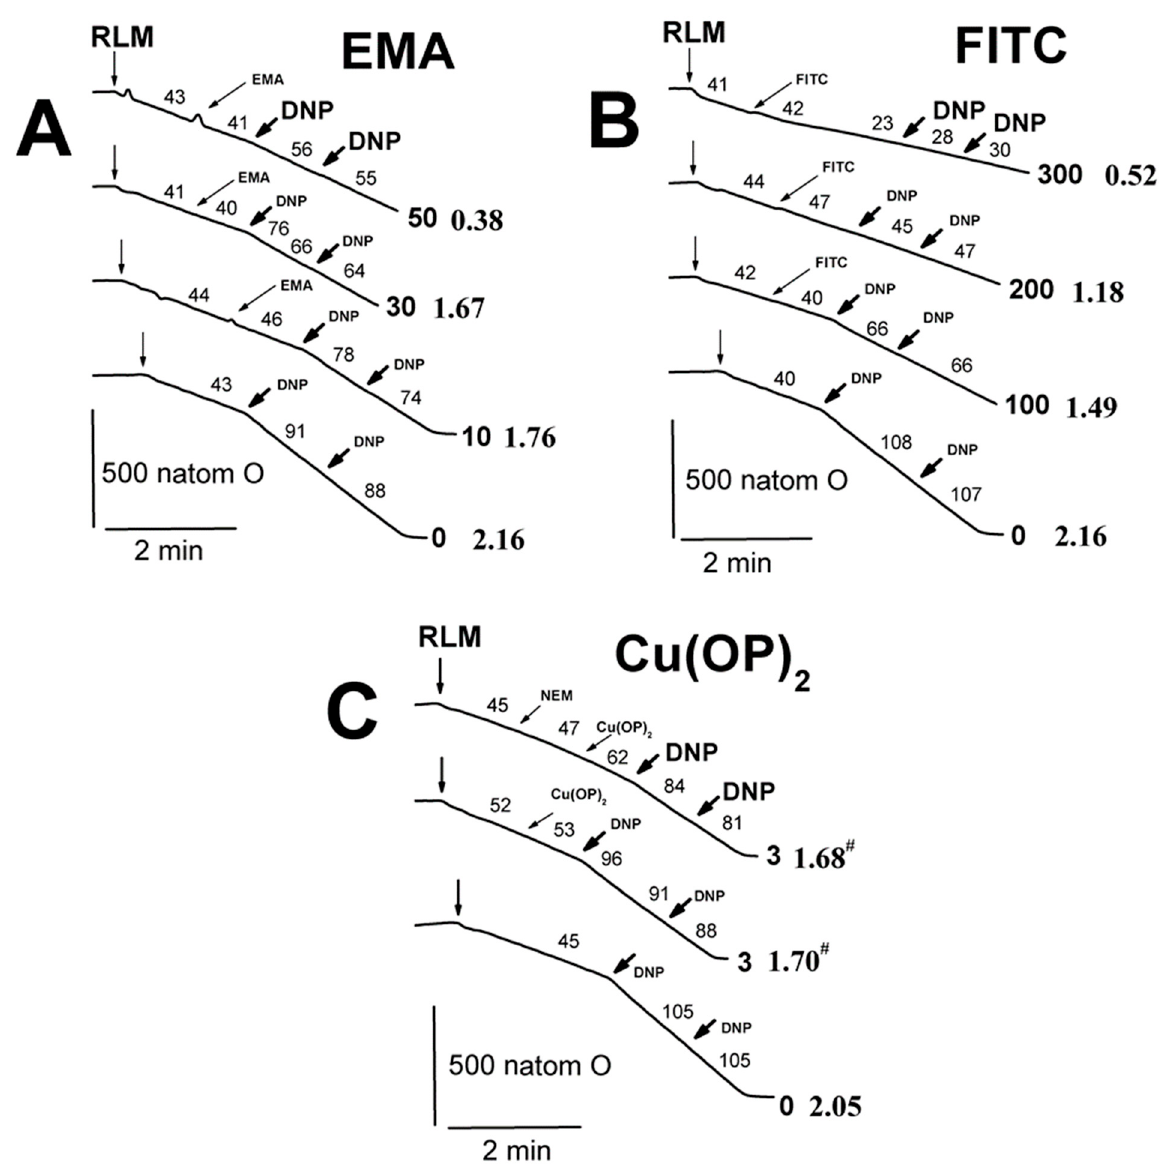
Figure 9. Influence of EMA, FITC, and Cu(OP) 2 on the oxygen consumption rates of rat liver mitochondria in the medium with 75 mM TlNO 3 . Mitochondria (1.5 mg/mL of protein) were injected into the medium A containing 5 mM succinate. Arrows show additions of mitochondria (RLM), 0–50 μ M EMA (EMA), 0–300 μ M FITC (FITC), 0–3 μ M Cu(OP) 2 (Cu(OP) 2 ), and double 15 μ M DNP (DNP). The numbers on the right of the traces show concentrations ( μ M) of EMA ( A ), FITC ( B ), Cu(OP) 2 ( C ). Oxygen consumption rates (natom O min/mg of protein) are presented as numbers placed above experimental traces. Numbers on the right of the traces in Times New Roman and bold show the RCR DNP values (see the Section 4, and for more detail, see the Supplementary Data). Hash signs on the right of latter numbers indicate that differences between appropriate values of the RCR DNP are statistically insignificant to the values found in experiments free of Cu(OP) 2 .